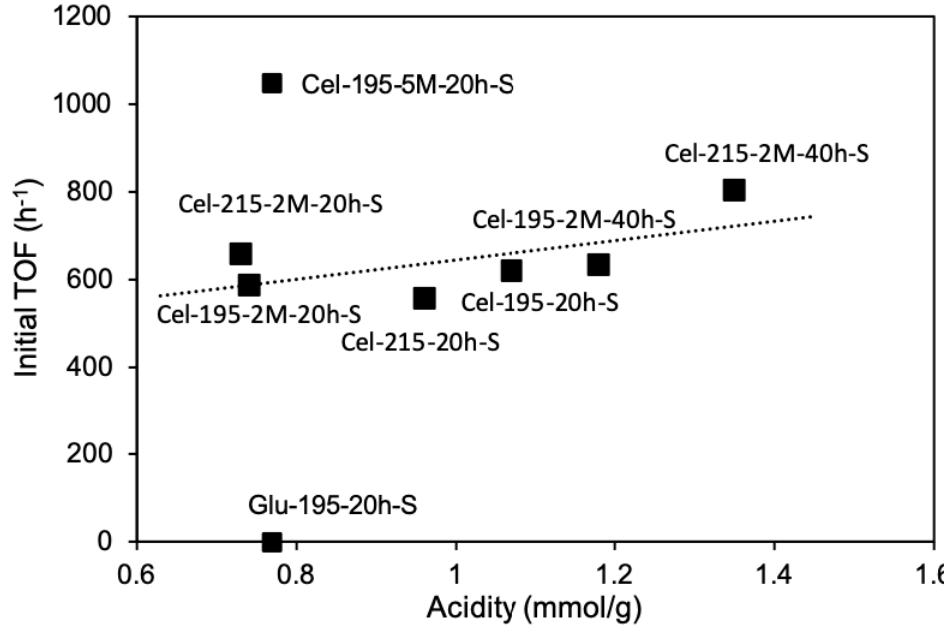
Figure 9. Initial TOF in solketal synthesis vs. sulfonic acidity plot with second-used SHTC as catalyst (reaction conditions: acetone: glycerol molar ratio 7:1, catalyst 1% w/w with respect to glycerol, 25 °C).